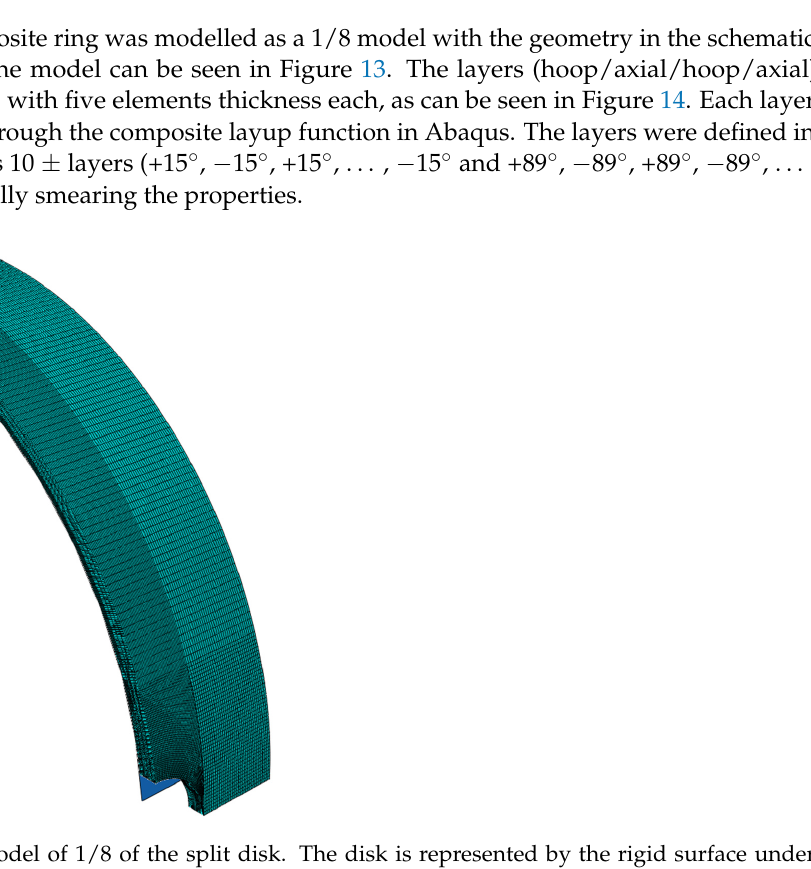
Figure 12. S-N curve for the shear component with data points.